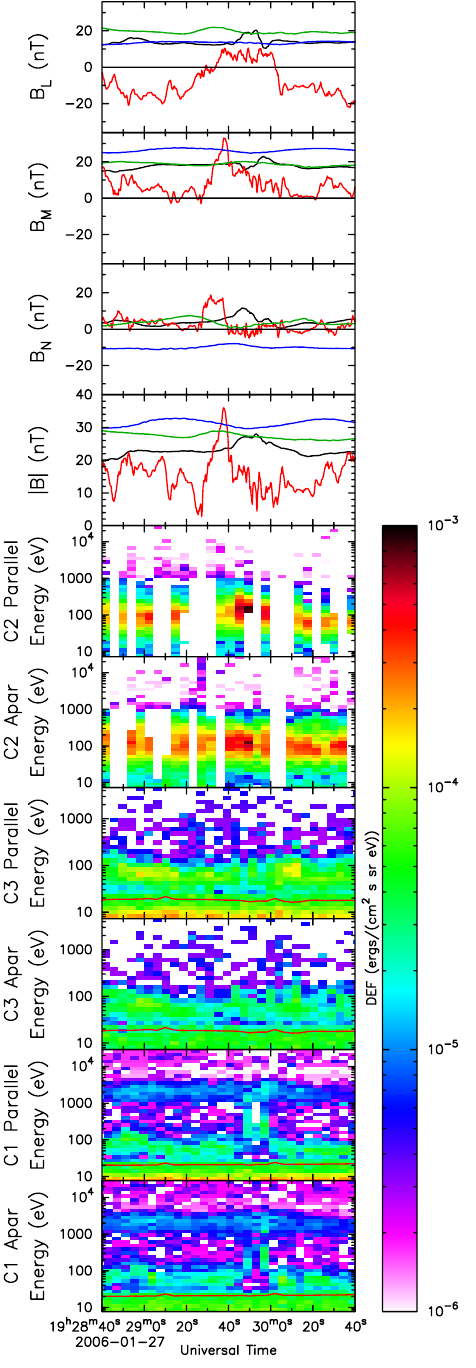
Fig. 6. An enlargement of the FTE signatures observed by the four Cluster spacecraft at 19:30UT. The panels show (from top), the magnetic field signatures (in boundary normal coordinates) ob- served by all four spacecraft, and then the parallel and antiparallel electron pitch angle distributions observed by Clusters 2, 3 and 1. The red line in the spectrograms shows the spacecraft